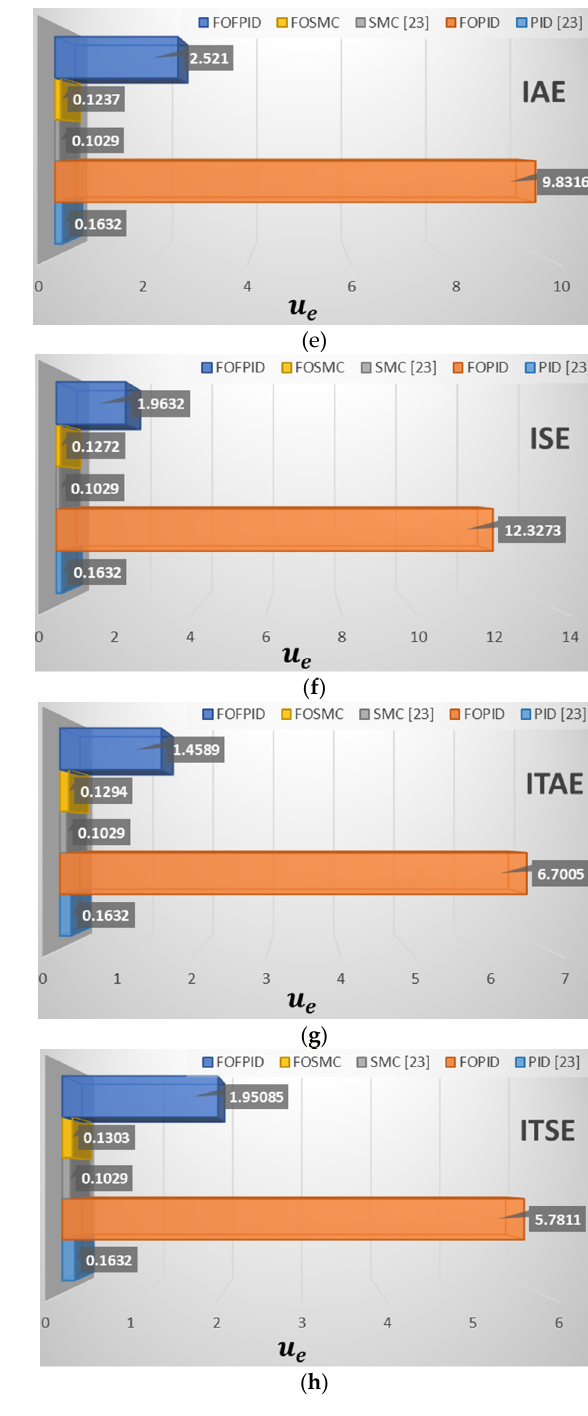
Figure 10. Dynamic response parameters ( a – d ) and control energy values ( e – h ) for the Maglev system with different controllers under parametric variation with +10%.